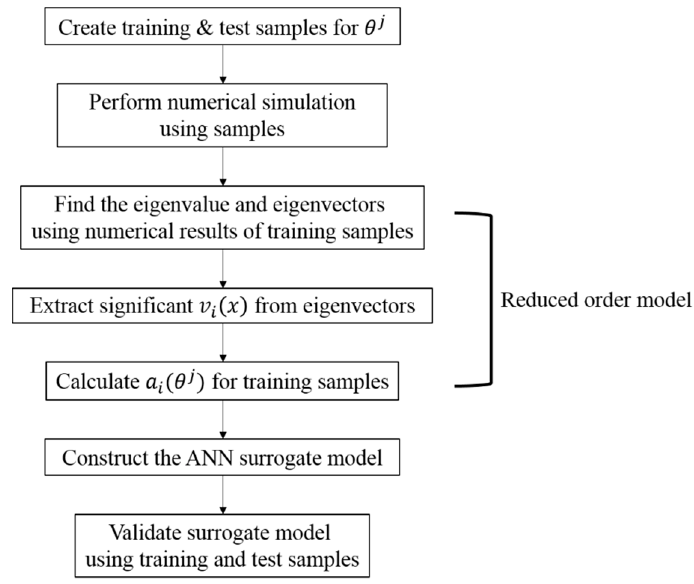
Figure 14. Flowchart for the construction of the surrogate model for the EHF simulation.